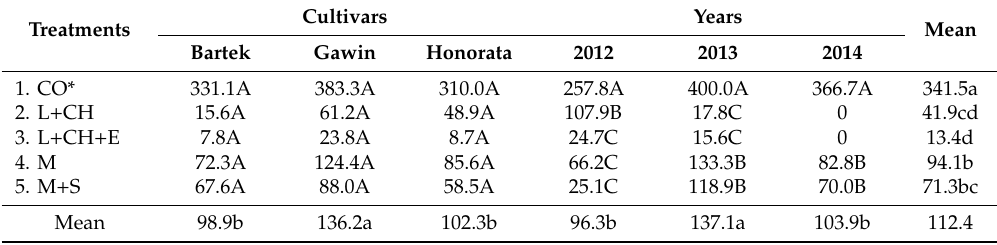
Table 3. Fresh weight of weeds in the field cultivated with potato before tuber harvest (g m − 2